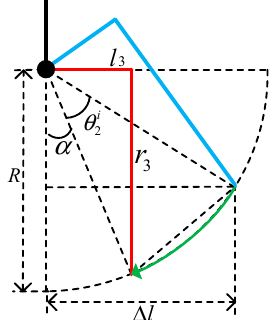
Figure 11. Extent of rotation of the knee joint by LSWM descent distance. The blue state ( ∆ h = 11 mm) indicates that the toe only just touches the ground, and the red state ( ∆ h = 36 mm) indicates the vertical stance. The green arrow indicates that the knee joint rotates from the blue to the red state.